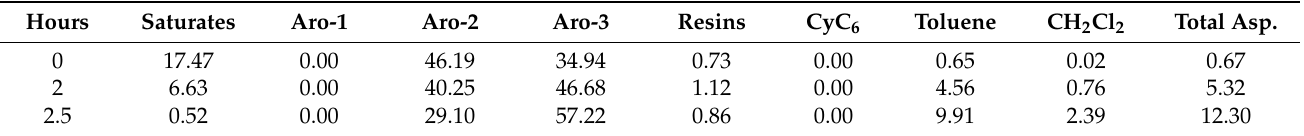
Table 5. SAR-AD data for FCC slurry oil pyrolyzed at 430 ◦ C at different retention times.